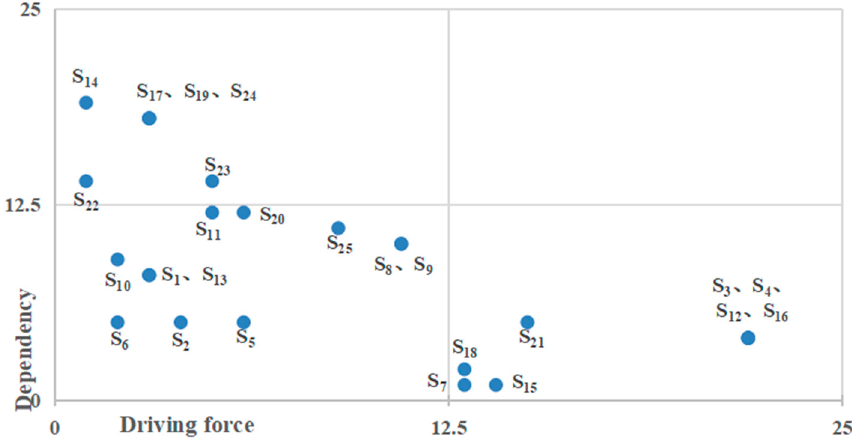
Figure 5. Cluster diagram from the MICMAC analysis.